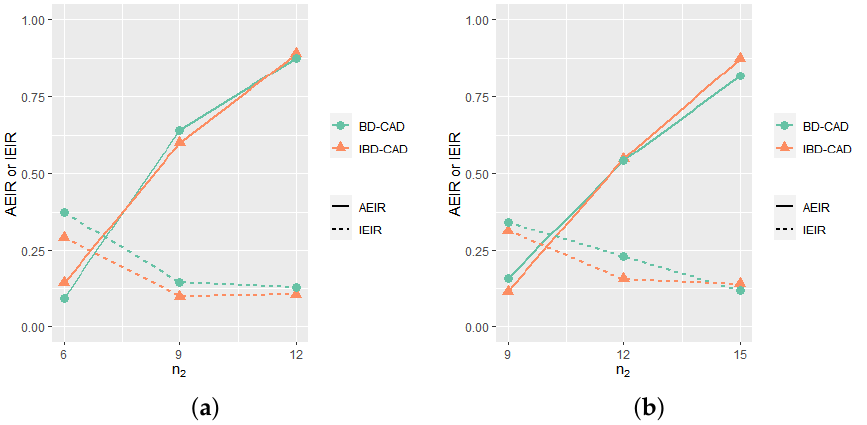
Figure 2. AEIR and IEIR versus the number of augmented design runs n 2 for β ∼ N ( 6,1 ) , r = 2. ( a ) SSD ( 8,13 ) . ( b ) SSD ( 7,15 ) .